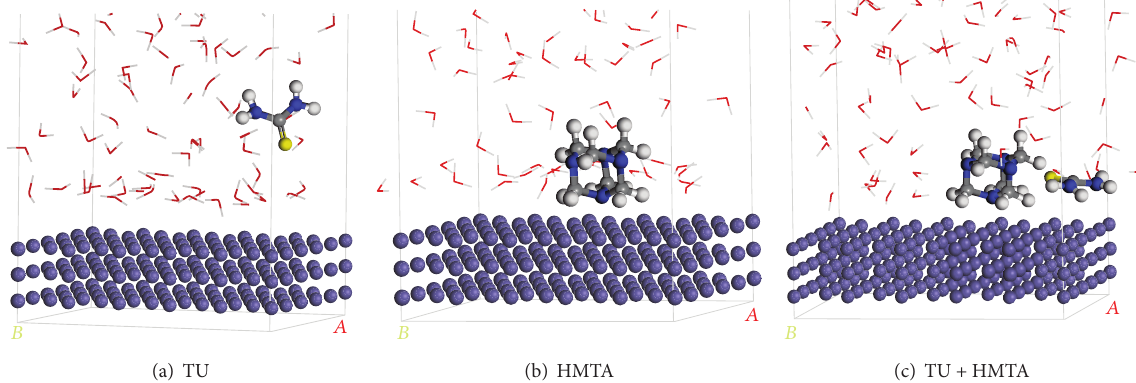
Figure 8: Mode of adsorption of inhibitors on the Fe (1 1 1) surface at 25 ± 1 ∘ C: (a) TU, (b) HMTA, and (c) TU + HMTA.